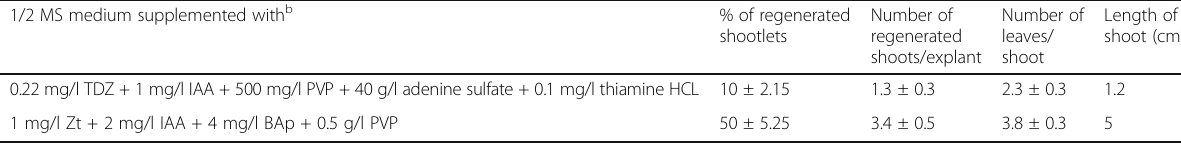
Table 3 Effect of supplementation of half MS nutrient medium with two concentrations of growth regulators on percentage, number of regenerated shoots/explant, number of leaves/shoot, and length of shoot (cm) induced from internode calli explants of Diospyros kaki L. cv. Costata a